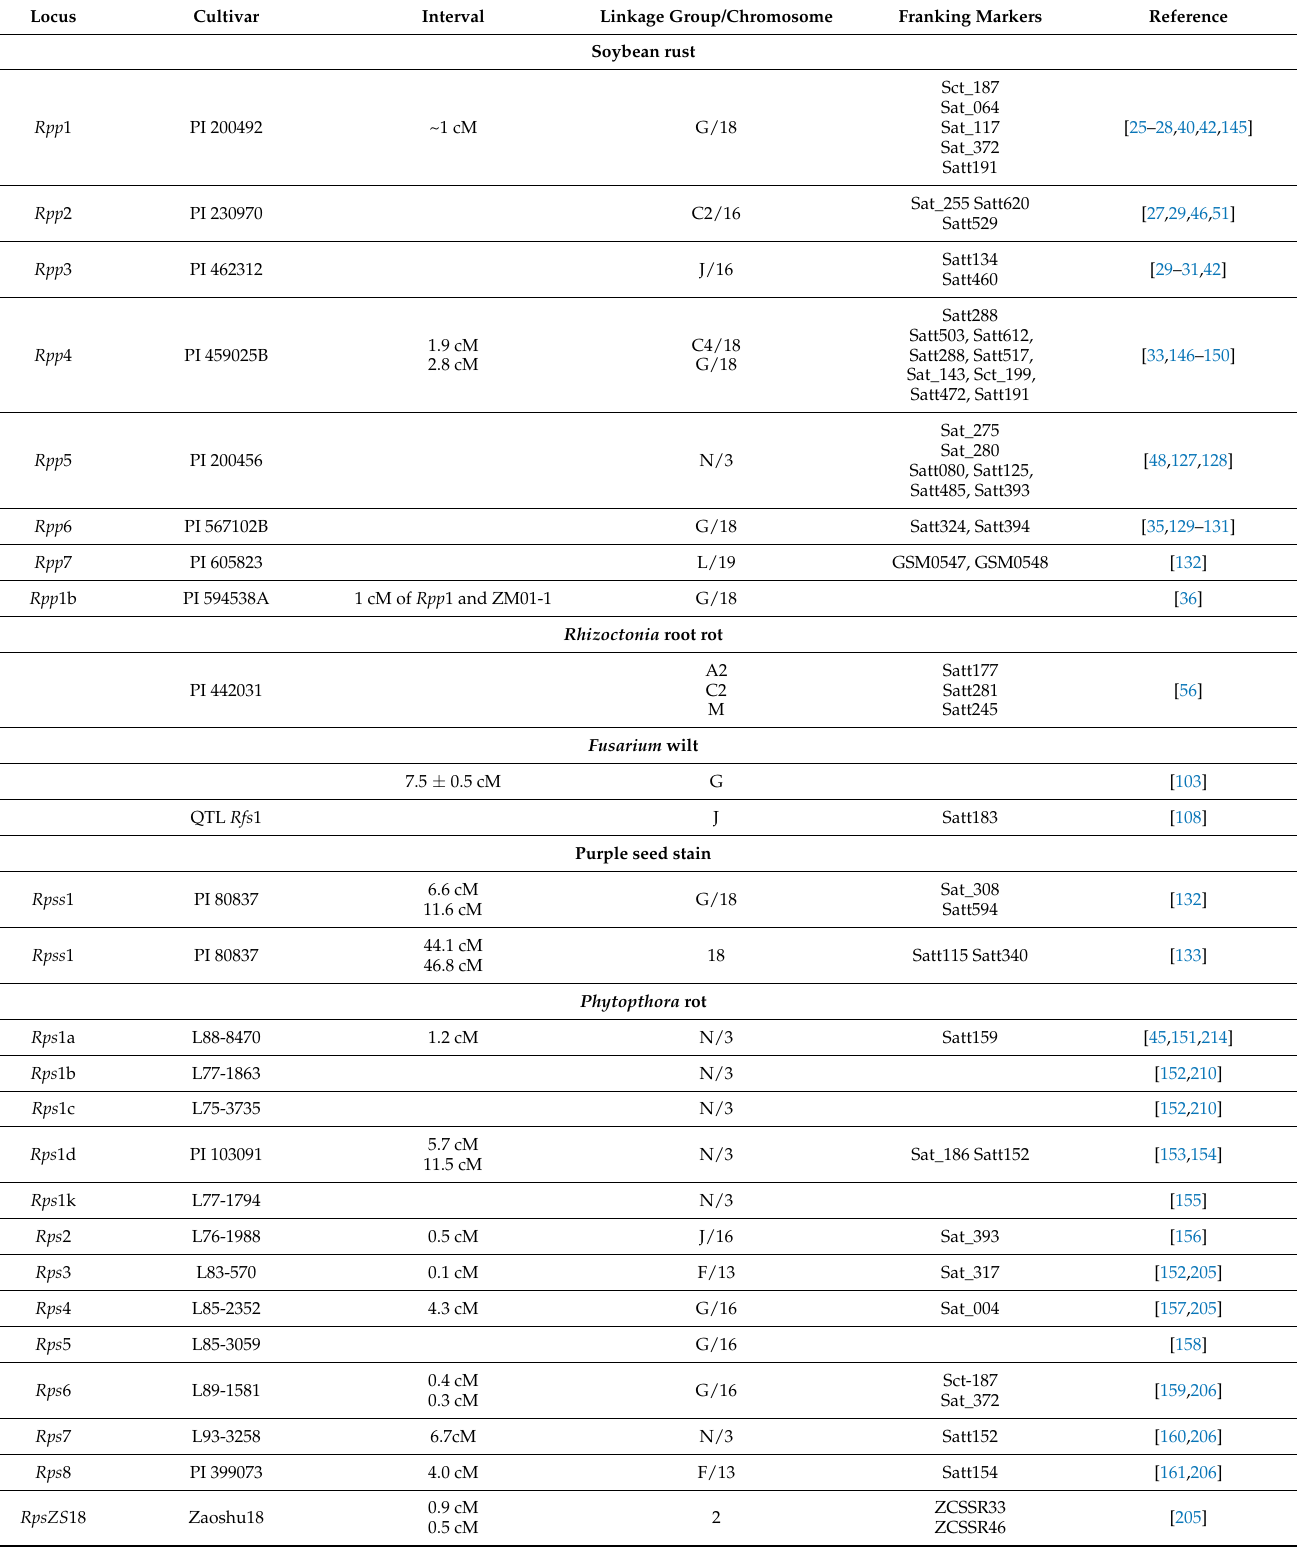
Table 1. Genes/markers reported to be linked with soybean resistance against different biotic